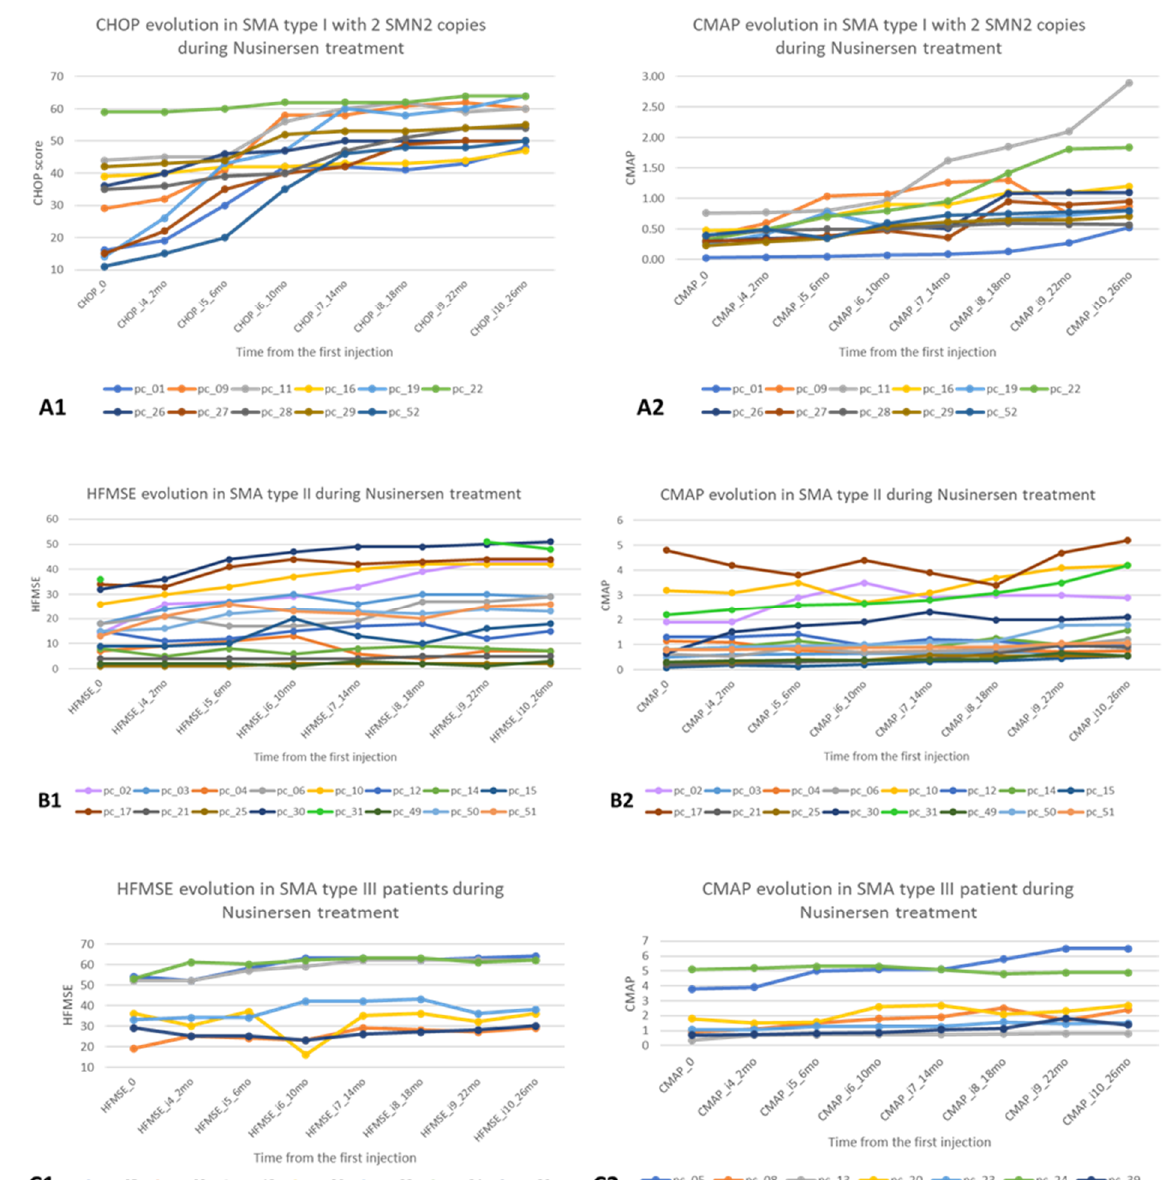
Figure 1. Motor and electrophysiological evolution in the first 26 months after starting nusinersen treatment for patients with SMA types 1, 2 and 3. ( A1 )—CHOP evolution in SMA type 1 with 2 copies of SMN; ( A2 )—CMAP evolution in SMA type 1 with 2 copies of SMN; ( B1 )—HFMSE evolution in SMA type 2; ( B2 )—CMAP evolution in SMA type 2; ( C1 )—HFMSE evolution in SMA type 3; ( C2 )—CMAP evolution in SMA type 3.